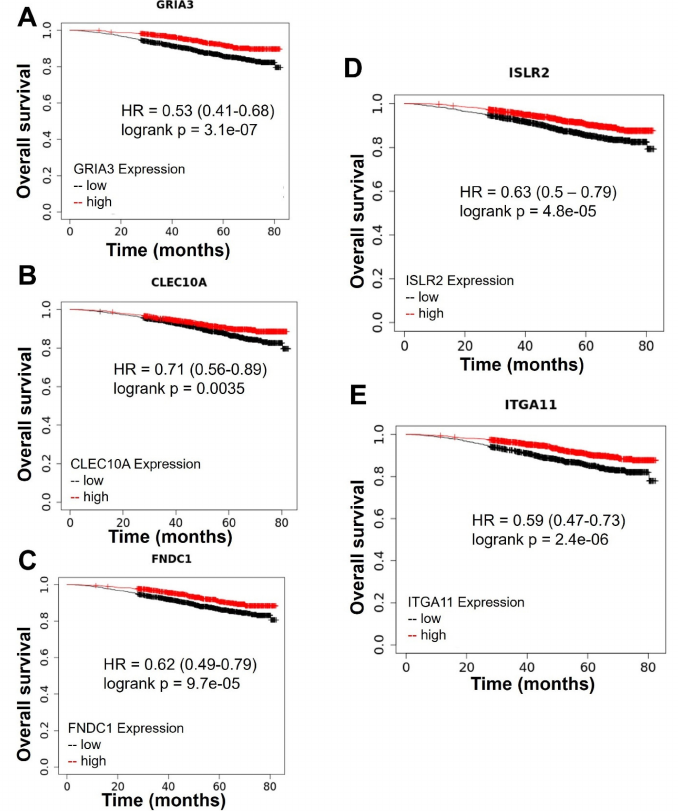
Figure 2. Top genes differentially expressed in tumors treated with MSU-42011 and bexarotene correlate with patient survival. Kaplan–Meier survival curves from the top 10 differentially expressed genes from MSU-42011 vs. bexarotene vs. control where expression is correlated with overall survival in breast cancer patients [n = 2976; 1259 high 1717 low in ( A ), 1220 high 1756 low in ( B ), 1252 high 1724 low in ( C ), 1588 high 1388 low in ( D ), 1703 high 1273 low in ( E )]. Data generated using KMPlot (http://www.kmplot.com, accessed on 26 July 2022). No stratification strategies were used. Cutoffs for high and low expression were determined by auto-cutoff tool based on false discovery rate and p value